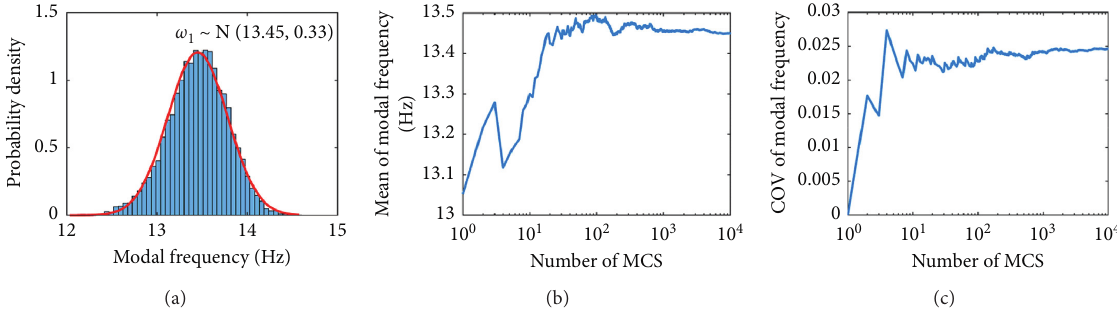
Figure 5: Histogram (a), mean (b), and COV (c) of the first-order modal frequencies based on 10,000 MCSs.